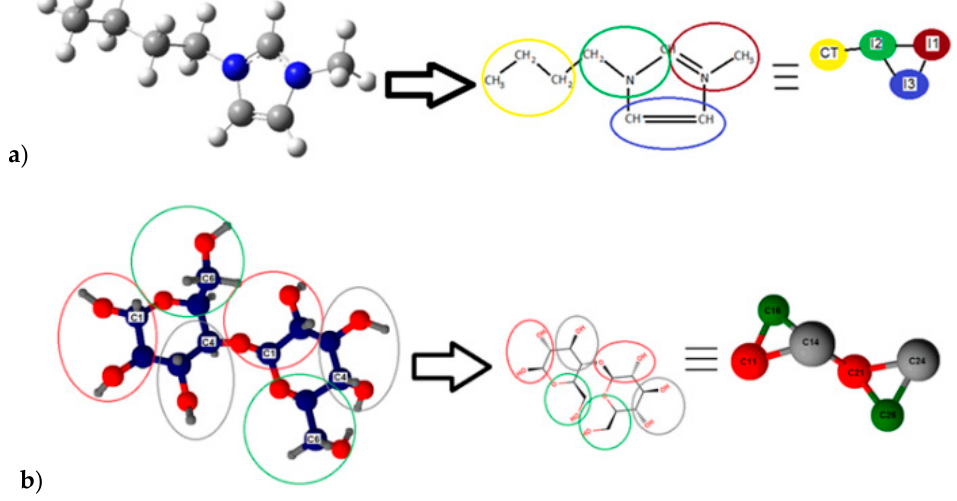
Figure 3. Coarse-grained models: ( a ) IL 1-butyl-3-methylimidazolium chloride ([bmim][Cl]) cation representation; ( b ) cellobiose representation.